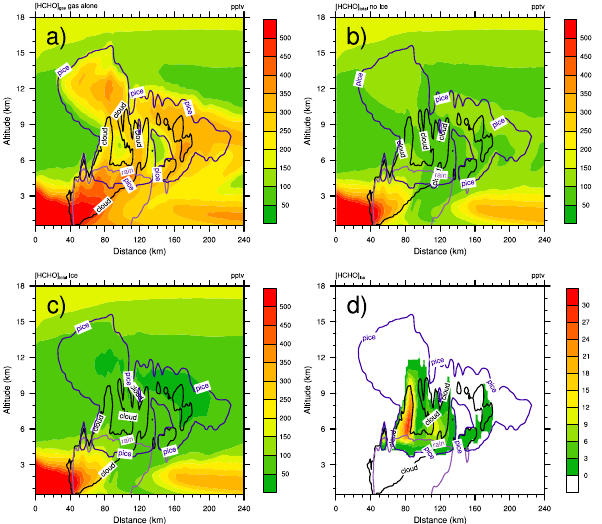
Figure 7. COPT case: simulated mixing ratio of formaldehyde during the mature stage of the 2 Fig. 7. COPT case – simulated mixing ratio of formaldehyde during the mature stage of the squall line: (a) simulated gas phase mixing squall line: a) simulated gas phase mixing ratio of HCHO for the GAS simulation, b) 3 ratio of HCHO for the GAS simulation, (b) simulated total mixing simulated total mixing ratio of HCHO (gas + cloud water + rainwater) for the AQ-NOICE 4 ratio of HCHO (gas + cloud water + rainwater) for the AQ-NOICE simulation, c) simulated total mixing ratio of HCHO (gas + cloud water + rainwater + 5 simulation, (c) simulated total mixing ratio of HCHO (gas + cloud precipitating ice) for the AQ-ICE simulation, and d) simulated mixing ratio of HCHO in 6 water + rainwater + precipitating ice) for the AQ-ICE simulation, precipitating ice for the AQ-ICE simulation. The black line is the 0.01 g/kg isoline cloud 7 and (d) simulated mixing ratio of HCHO in precipitating ice for the water mixing ratio, the purple line is that for precipitating ice (snow + graupel) and the mauve 8 AQ-ICE simulation. The black line is the 0.01gkg − 1 isoline cloud is that for rainwater. 9 water mixing ratio, the mauve line is that for precipitating ice (snow + graupel), and the purple is that for rainwater.